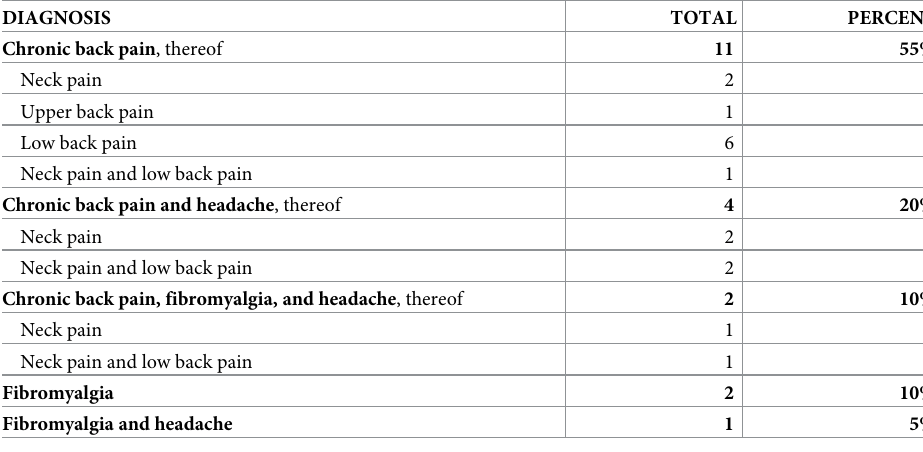
Table 1. Pain types in chronic pain patients (n =